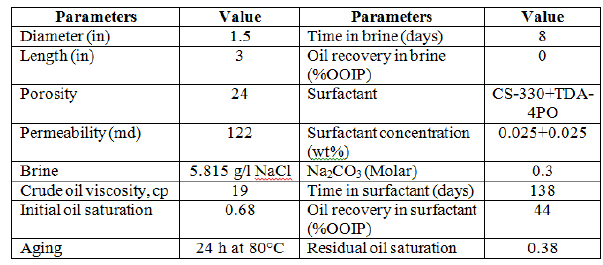
Table 2: The properties of the core used for the absorption experi- ment